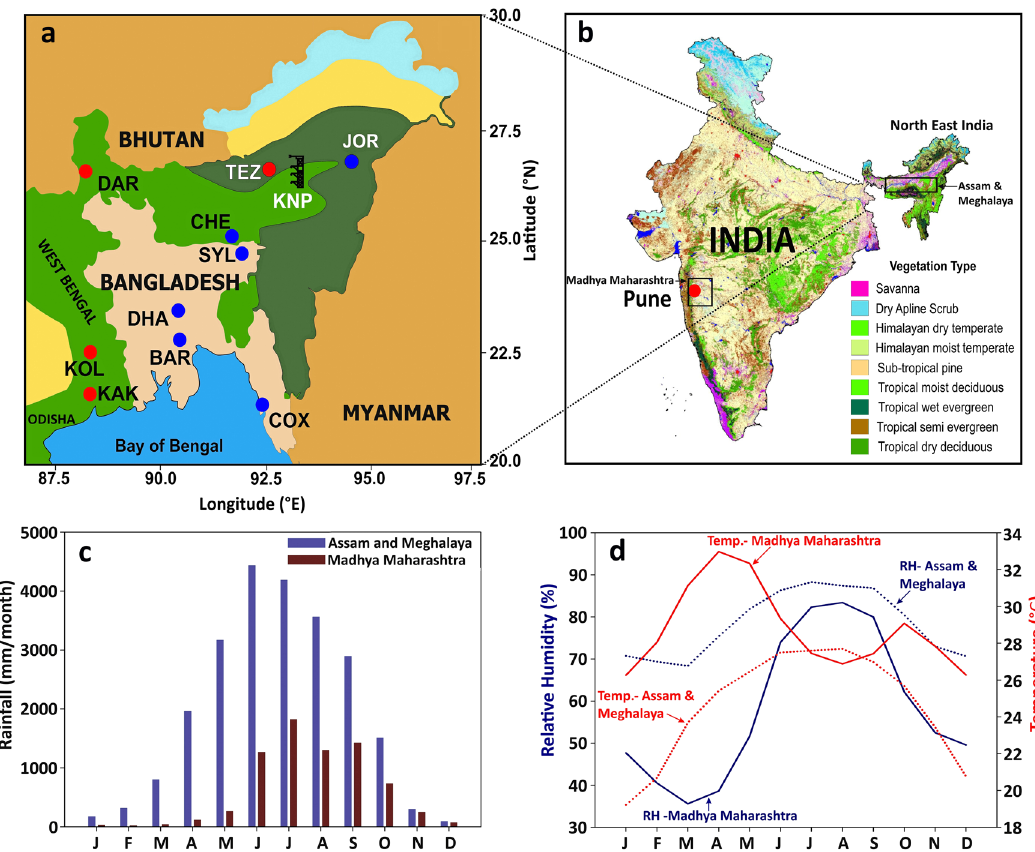
Fig. 1 Study area and site description. a Map of northeast India depicting the study area. The precipitation samples collection sites are Tezpur (TEZ), Darjeeling (DAR), Kolkata (KOL), and Kakdweep (KAK; all in red dots). The Kaziranga forest site (KNP) containing the eddy- covariance tower is shown. The published data of precipitation isotopes are available from Jorhat (JOR), Cherrapunjee (CHE), and the sites in Bangladesh (Dhaka, Sylhet, Barishal, and Cox Bazar; blue dots) are also shown in this map. b The India map and its vegetation types are illustrated. As revealed in this diagram, the forest cover in northeast India is much higher than the rest of the country. c The climatological (1871 – 2016) variation of rainfall on a monthly scale for Assam and Meghalaya (blue bar) and Madhya Maharashtra (containing the Pune city) (dark red bar) has been shown. d The monthly variations of temperature and relative humidity for the above mentioned two regions are also